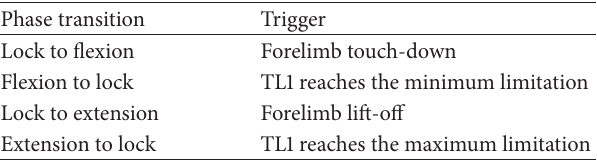
Table 3: Phase transition rules of